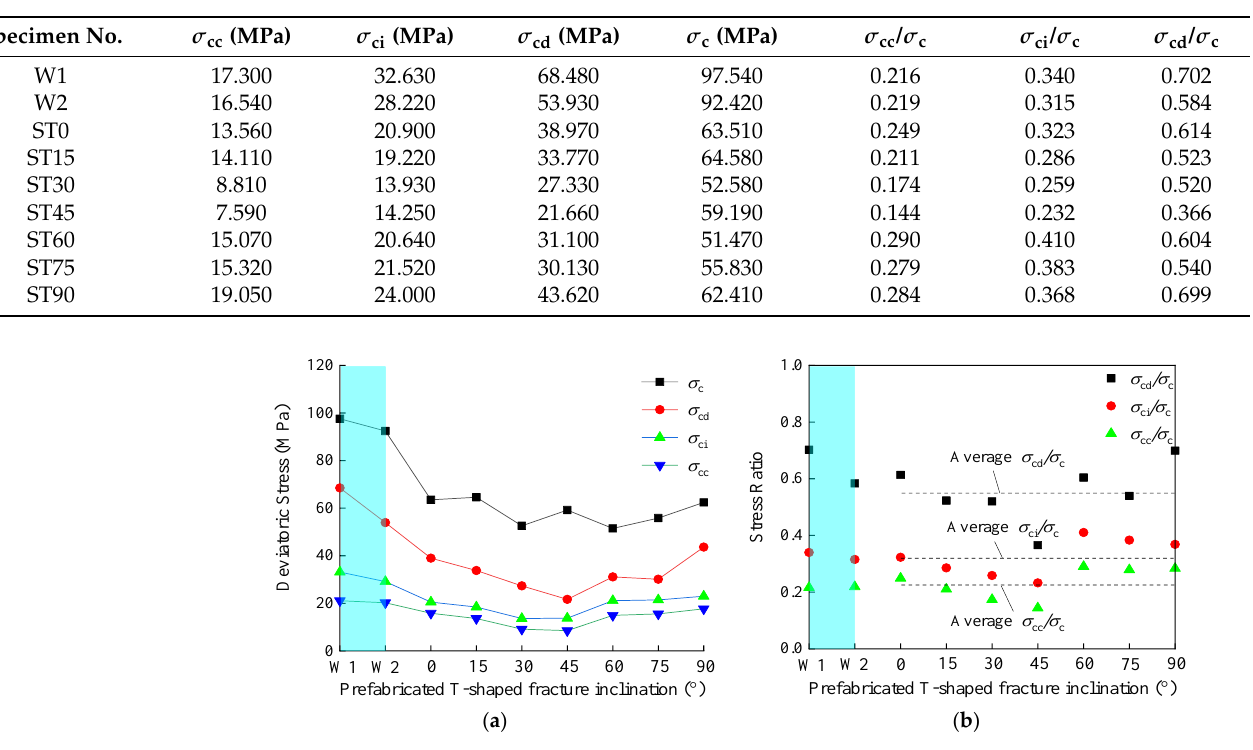
Figure 6. Relationship between fracture inclination and different thresholds, stress ratios of intact and T-shaped fracture samples: ( a ) Relationship between different thresholds and fracture inclination; ( b ) Relationship between stress ratio and fracture inclination.